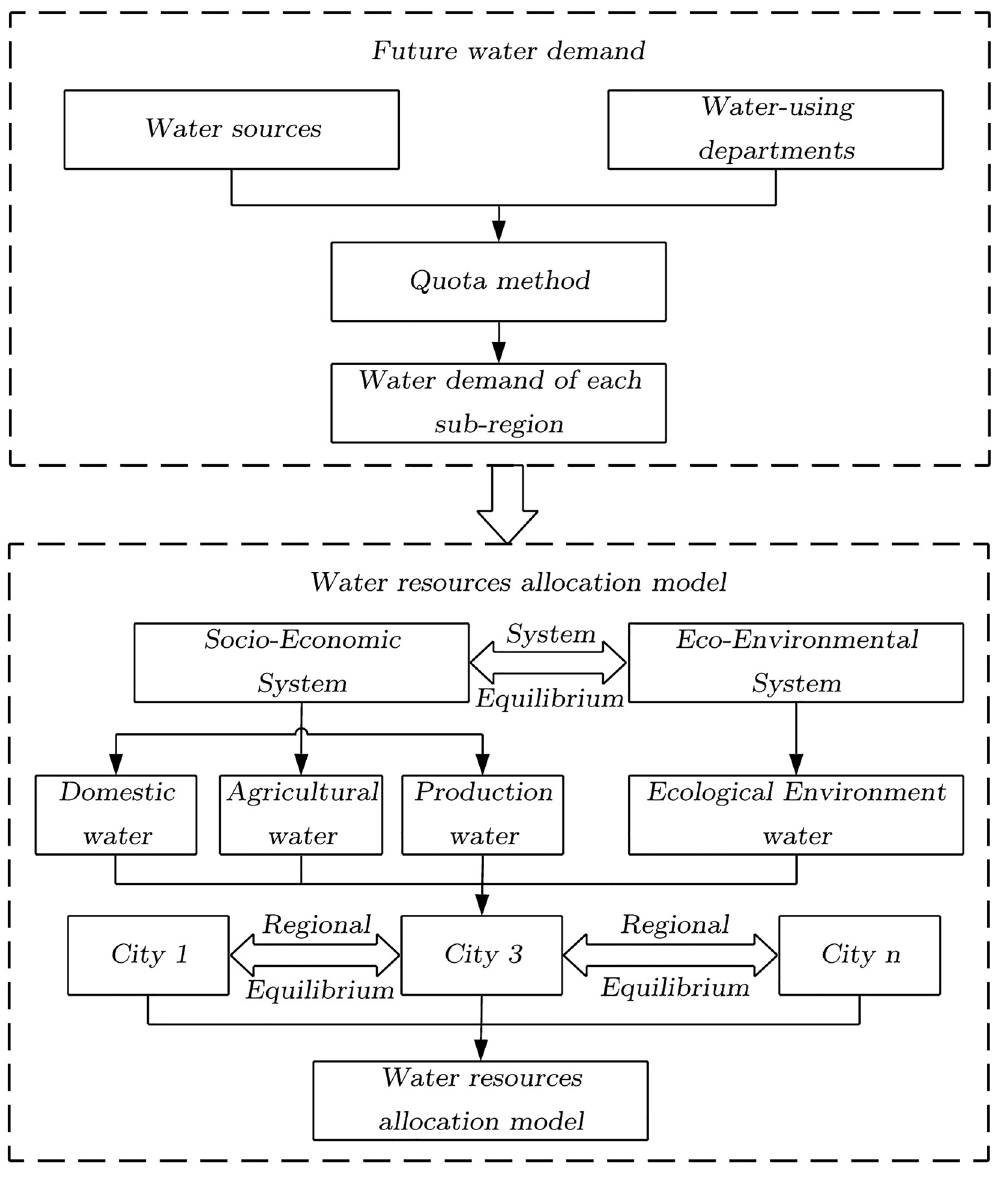
Figure 1. Flowchart of the